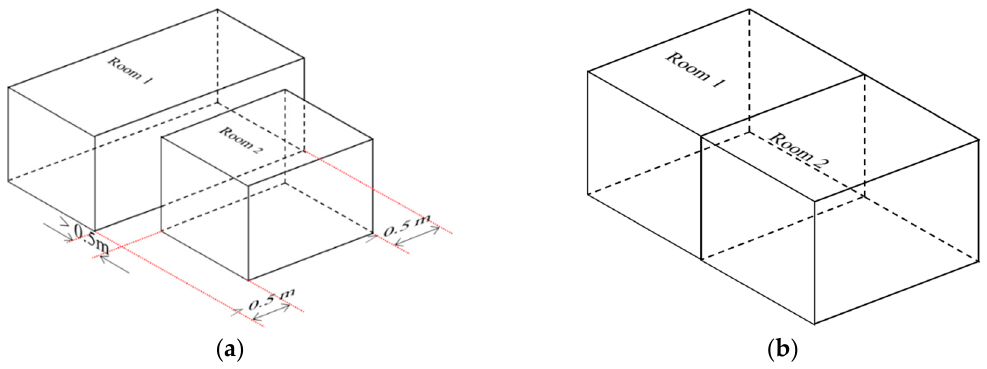
Figure 20. Schema of the correction of planes: ( a ) Before the correction; ( b ) After the correction. At this point, the planes of each room are intersected. With 6 planes per room, 8 intersection points are obtained, which are the vertexes of each room. After generating the gbXML schema with these data, one last correction is needed, as explained in Section 1: if any wall corresponding with the intersection wall between two rooms is duplicated, one of the polygons is deleted for this wall and the polygon left is used to define the wall for gbXML. This polygon is assigned to the two adjacent spaces, one for each adjacent room. The whole process with user interactions lasts 427 s.